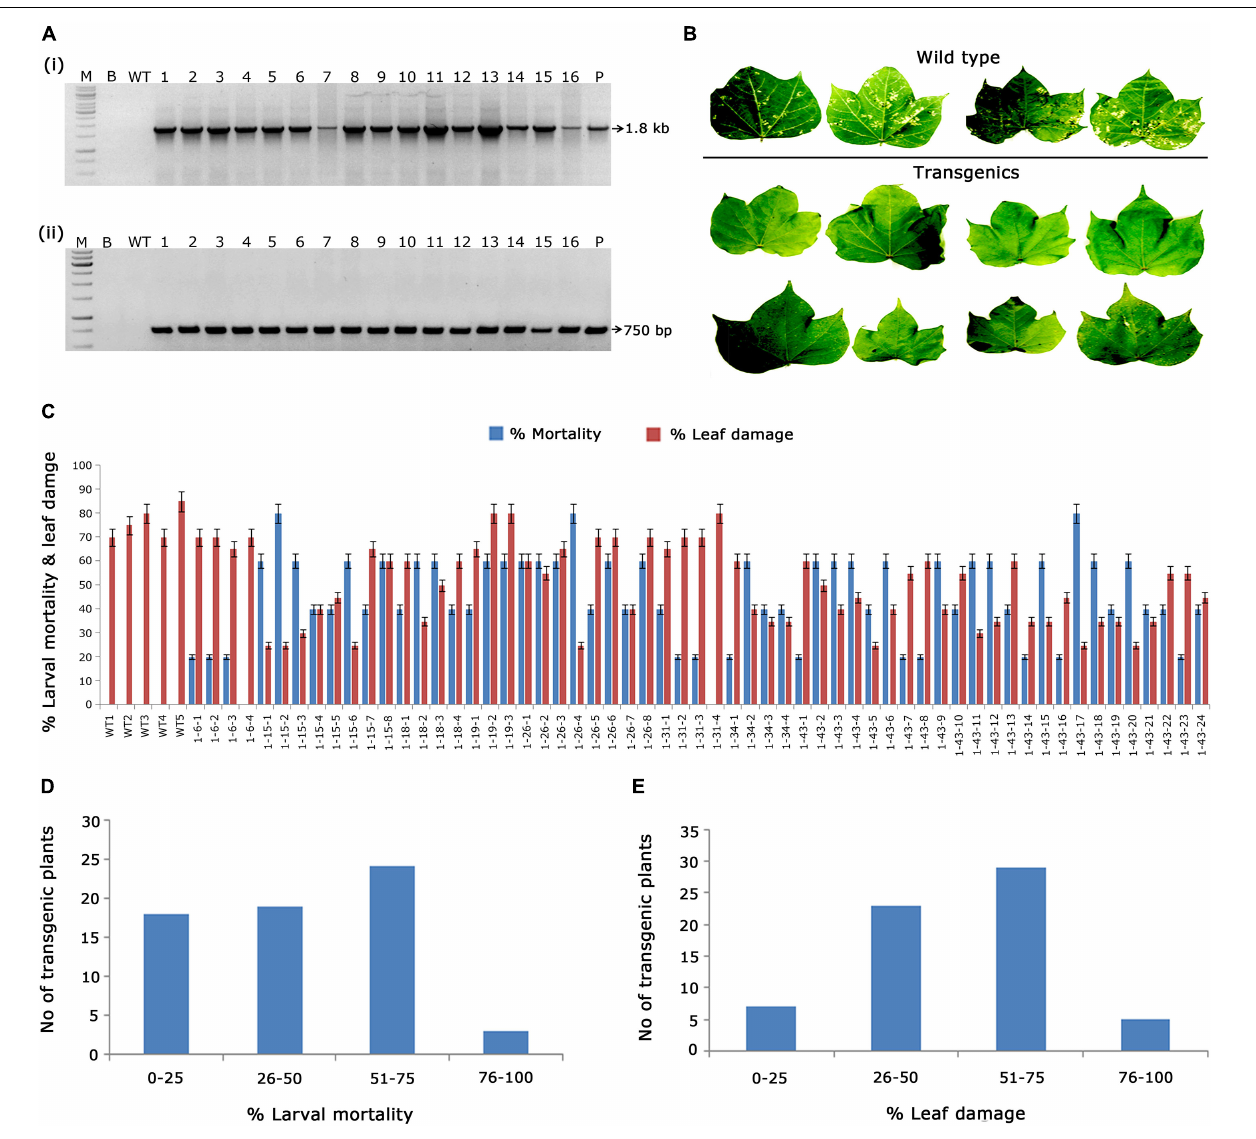
FIGURE 2 | Molecular analysis of cry1AcF cotton transformants in T 1 generation. (A) Polymerase chain reaction (PCR) analysis of T 1 generation cry1AcF plants for the amplification of (i) 1.8 Kb cry1AcF gene and (ii) 750 bp nptII gene. Lane M – 1 Kb Ladder (Thermo Scientific), Lane B – water blank (all PCR components without template DNA), Lane WT – wild type (100 ng), and Lanes 1–16: T 1 generation transgenic plant DNA (100 ng). Lane P – positive control pBinAR cry1AcF (25 ng). (B) Representative leaves of wild type and transgenic plants challenged with Helicoverpa armigera in a detached leaf bioassay. (C) Graphical representation of the performance of 59 transgenic plants and wild type in terms of percentage of larval mortality and leaf damage. (D,E) Overview of the efficacy of transgenic plants against deliberate challenging of H. armigera larvae.